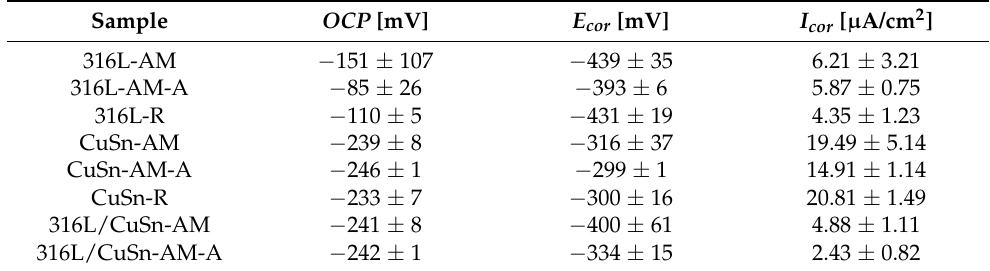
Table 4. Determined characteristic values of the LSV investigations.